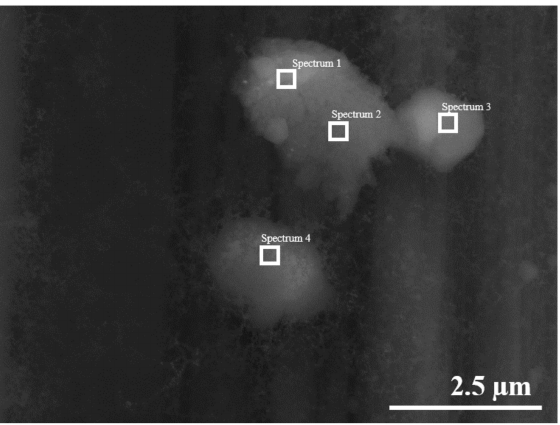
Figure 8. Determination of carbon clusters composition by